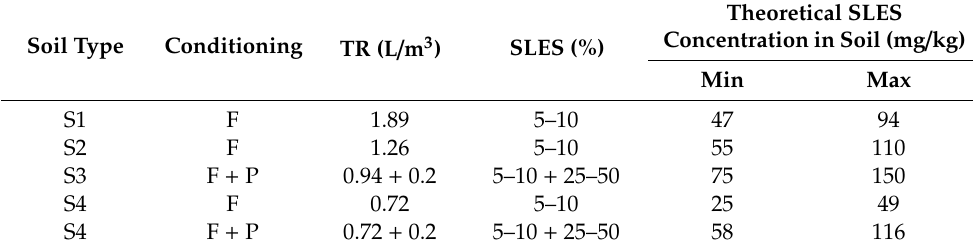
Table 2. Experimental conditions and treatment ratio values (TR, L / m 3 ) of the foaming agent (F) and polymer (P) used for soil conditioning of the four di ff erent soils (S1, S2, S3 and S4); minimum and maximum SLES (%) in each product; theoretical SLES concentrations calculated for each soil conditioned (mg /